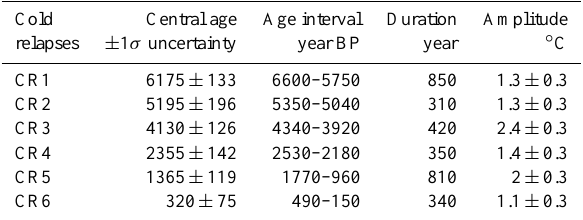
Table 2. Timing of Holocene cold relapses (CRs). Age uncertainty was estimated using a Bayesian approach of OxCal 4.2. The cooling amplitudes were determined by the difference between temperature at the beginning of CR and the lowest value after applying a 60 years Fast-Fourier Transform (FFT)